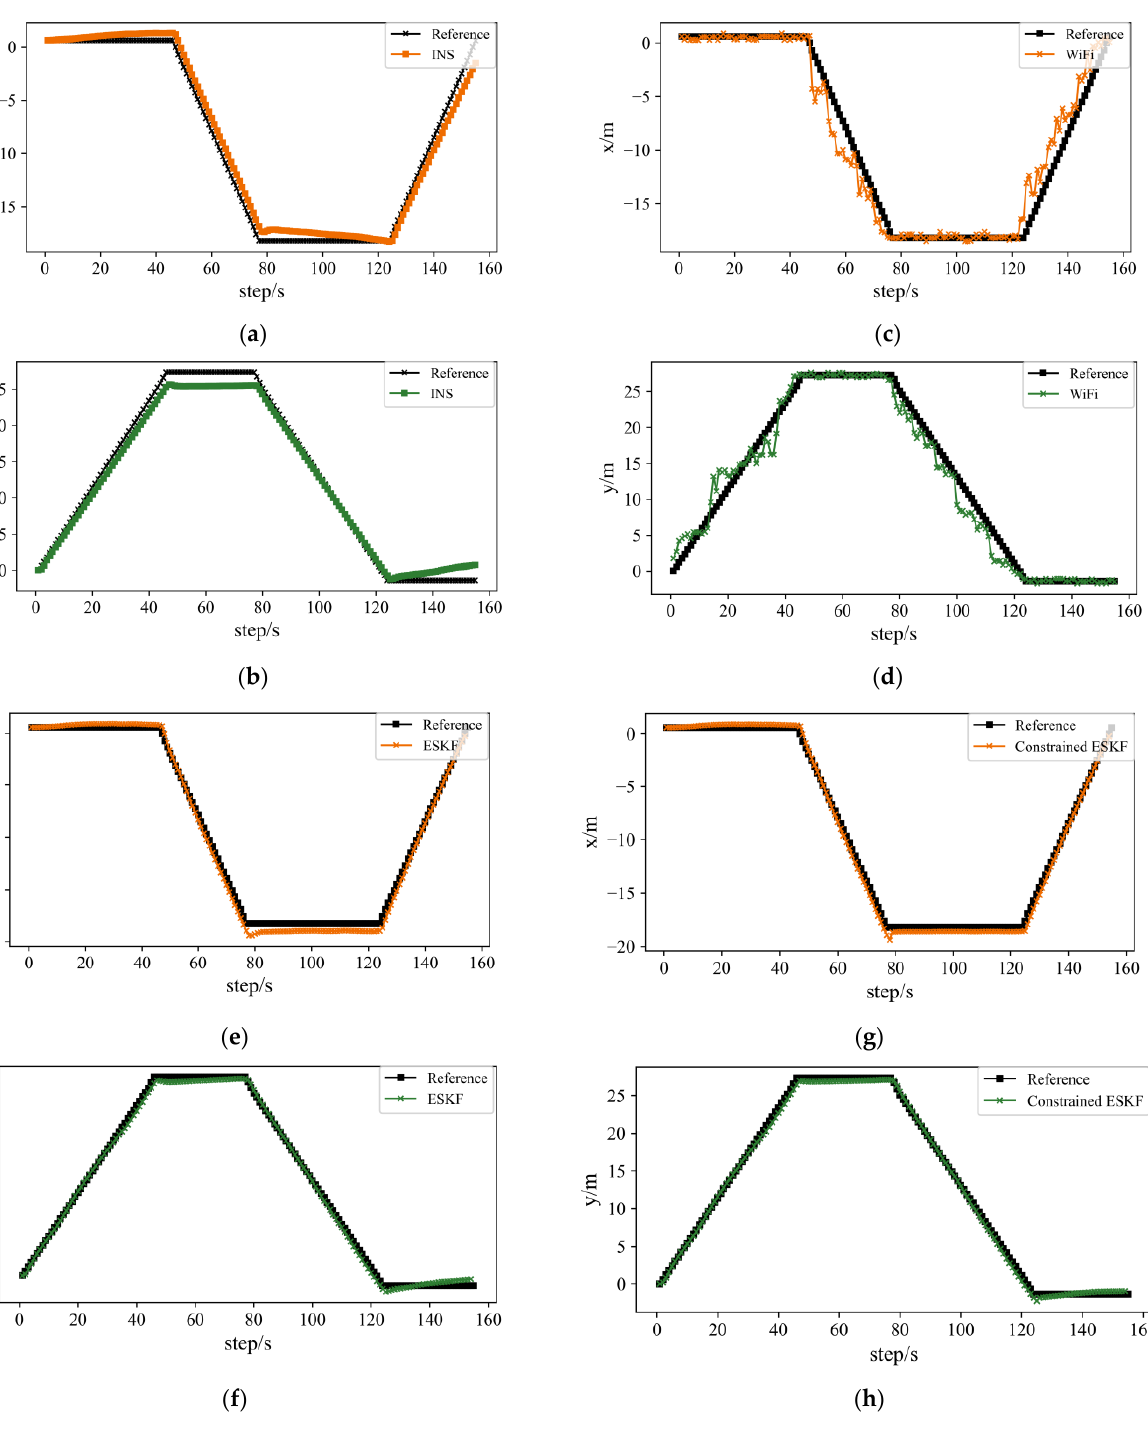
Figure 10. Figures of all methods comparison with reference trajectory: ( a , b ) are comparison figures of IMU-based method; ( c , d ) are comparison figures of WiFi-based method; ( e , f ) are comparison figures of ESKF-based data fusion method; ( g , h ) are comparison figures of constrained ESKF method.